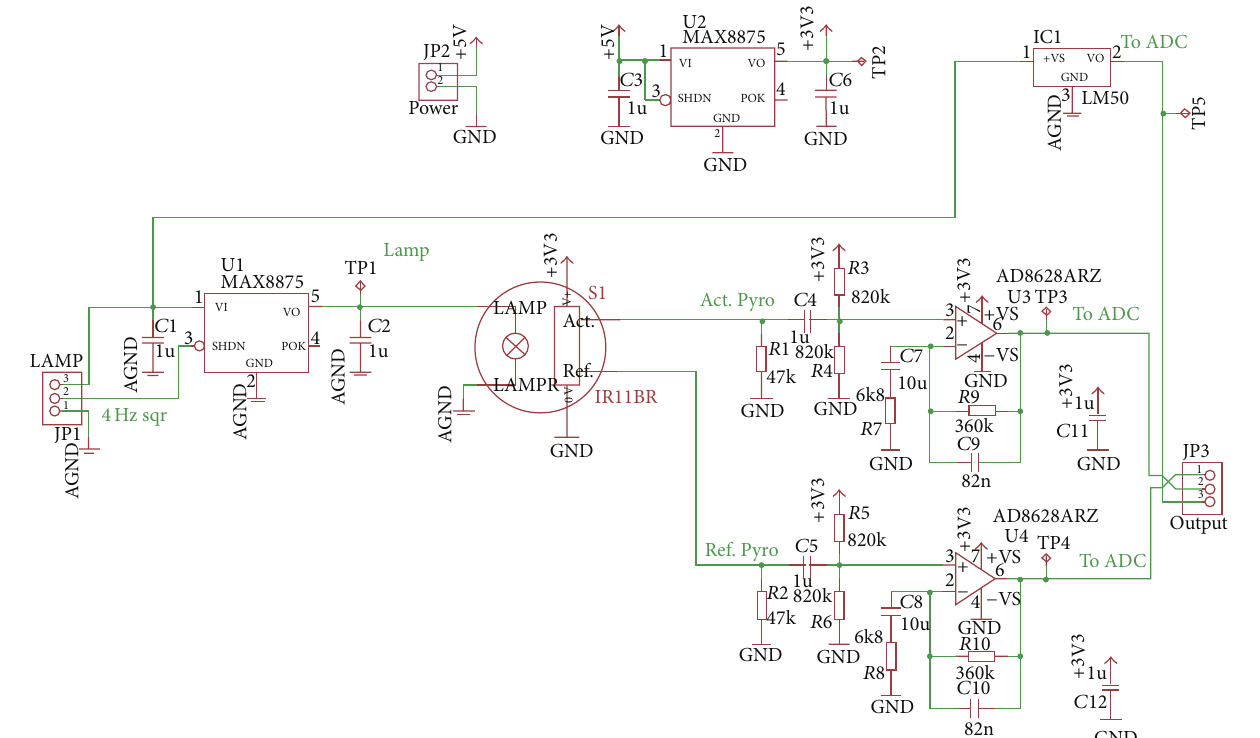
Figure 10: Circuit designed for CO 2 signal conditioning.